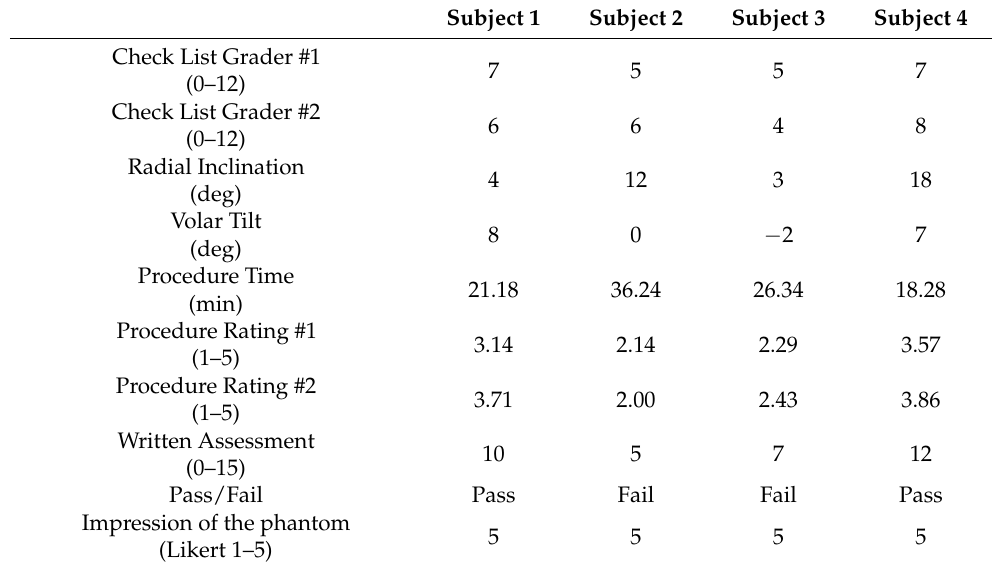
Table 1. Sample OSATS performance scores from 2019 for DRF management resident training performed on our phantom; adapted from [1]. The written exam is found in Appendix